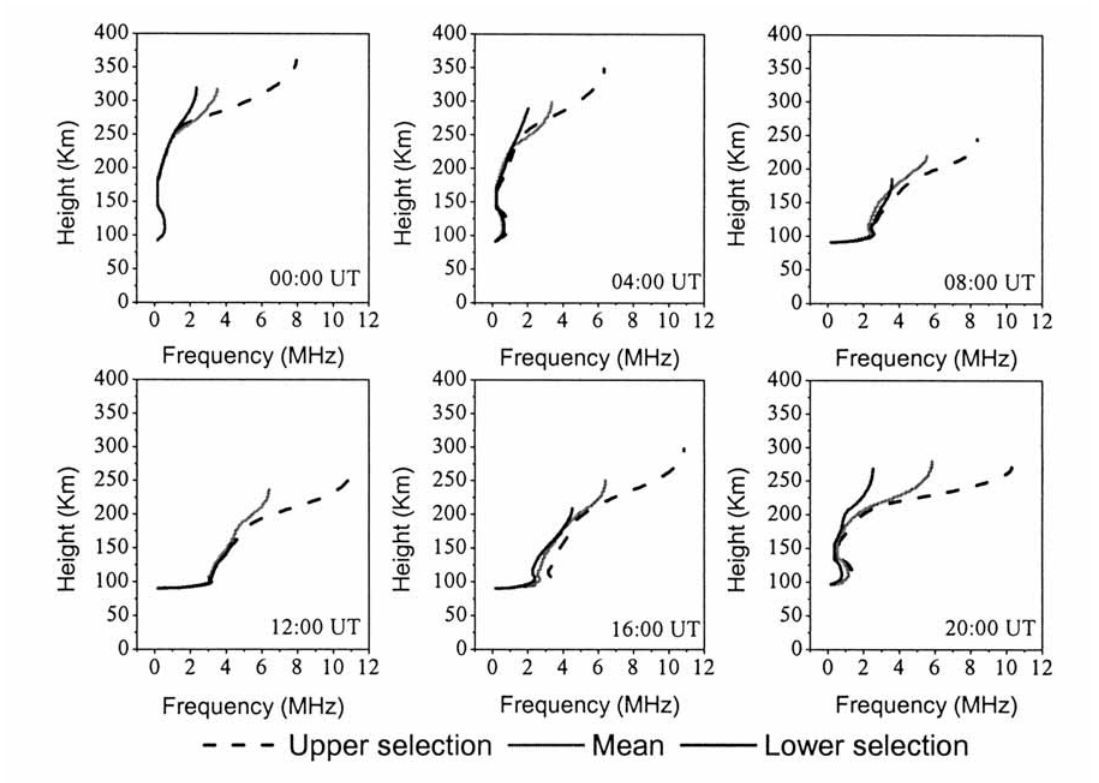
Fig. 1. Hourly monthly electron density profiles and the corresponding to upper and lower selection at El Arenosillo Atmospheric Sounding